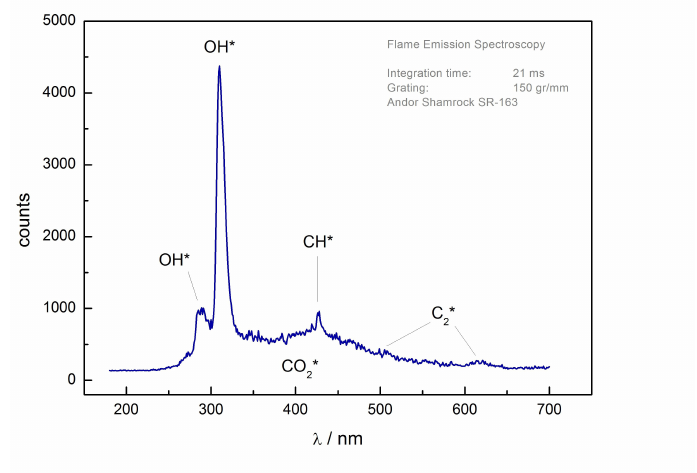
Figure 3. Flame emission spectrum of a LOX/LCH 4 combustion at 11.5bar